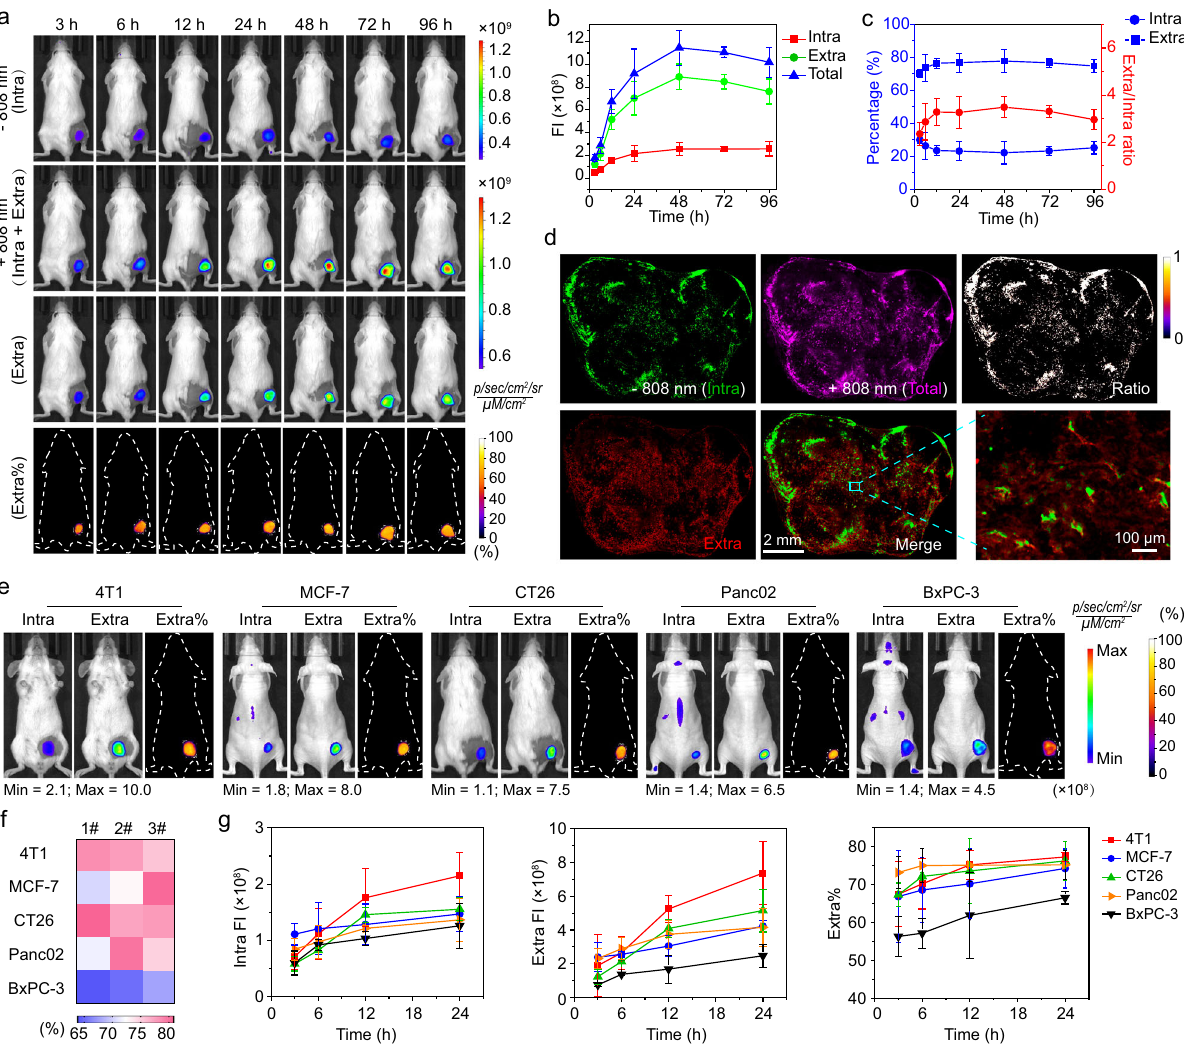
Fig. 4 Quantitative imaging of extracellular and intracellular distribution of nanoparticles in different tumors. a The pre- and post-irradiated Cy5 fl uorescence images, calculated extracellular Cy5 fl uorescence images, and the ratiometric images of extracellular signals versus post-irradiated fl uorescence signals of 4T1 tumor-bearing mice at different time points post-injection of MRIN. b The time-dependent pro fi le of intracellular, extracellular, and total nanoparticle exposure in 4T1 tumor sites over 96 h ( n = 4 biologically independent mice). c The percentages of intracellular and extracellular distributions of MRIN as well as the ratio of extracellular exposure to intracellular ones in 4T1 tumor sites over 96 h ( n = 4 biologically independent mice). d The intracellular, extracellular, total distribution of nanoparticles in tumor sections at 24 h post-injection of MRIN. The merged image showed the unambiguous differentiation of extracellular and intracellular nanoparticles. The ratiometric images of intracellular exposure of nanoparticles were also calculated. e Dissecting the intracellular and extracellular distribution of NPs in different tumors at 24 h post-injection of MRIN. f Heat map shows the percentages of extracellular nanoparticles in various tumor models at 24 h post-injection of MRIN ( n = 3 biologically independent mice). g The quantitative intracellular and extracellular nanoparticle exposure in different tumors at different time post-injection ( n = 3 biologically independent mice). The percentages of extracellular nanoparticles ranged from 50-80% of total accumulated NPs over 24 h. All data were presented as mean ±